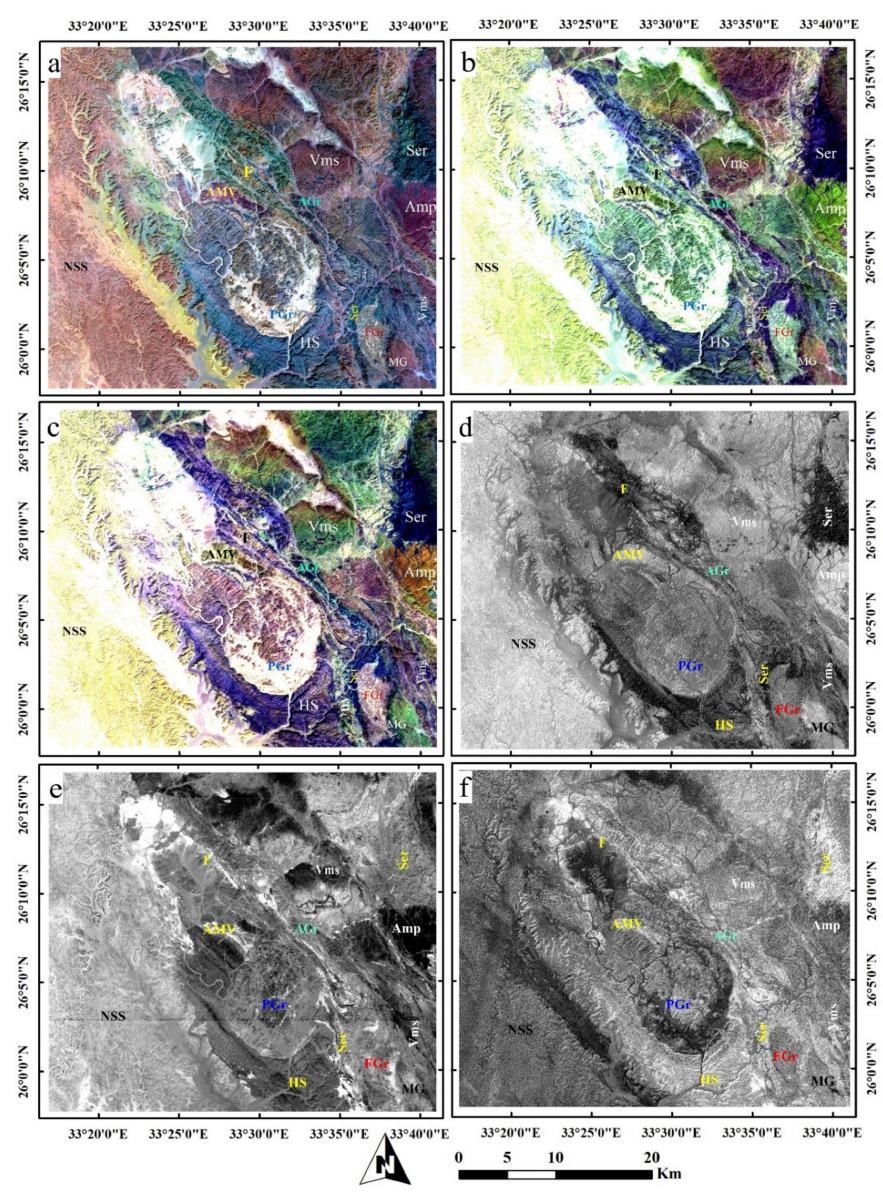
Figure 6. Lithological discrimination via ( a ) RGB b4, b3, and b1; ( b )RGB b4, b7, and b3; and ( c ) RGB b7, b4, and b3 ASTER FCCs. ASTER band ratios of ( d ) (4/2), ( e ) (4/6), and ( f ) (5/6) for mapping gossan, advanced argillic, and argillic-phyllic alteration as bright pixels,